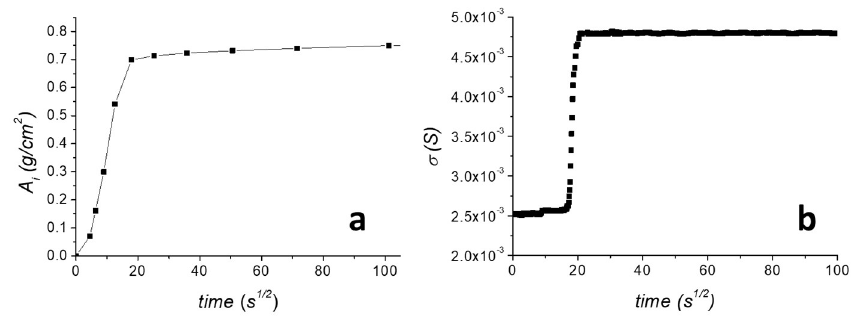
Figure 4. ( a ) Water capillary absorption curve of untreated TUFF specimen. ( b ) Surface conductivity profile recorded at the sides of the MMT/rGO sensor applying a 3 V voltage during the water